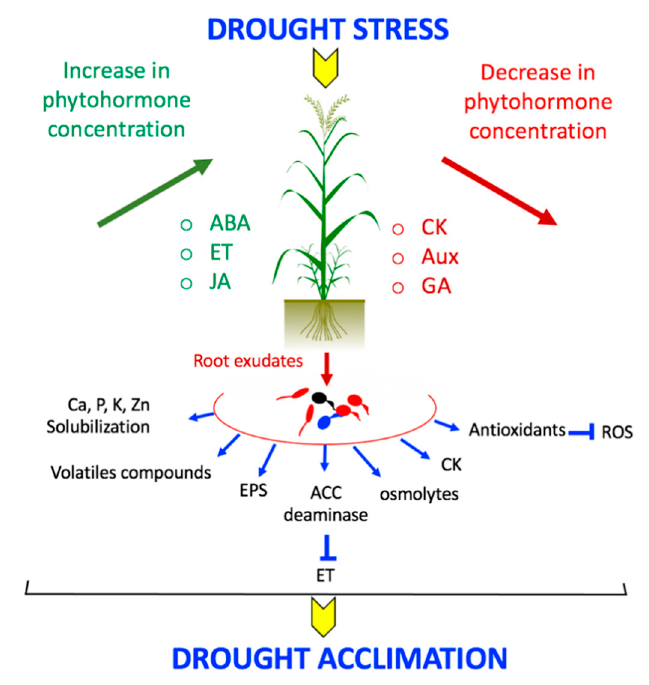
Figure 2. Hormonal changes in wheat during drought stress with the impact of rhizosphere bacteria. ABA: abscisic acid; EPS: exopolysaccharides; ET: ethylene; JA: jasmonic acid; CK: cytokinin; Aux: auxin; GA: gibberellin, ROS: reactive oxygen species.